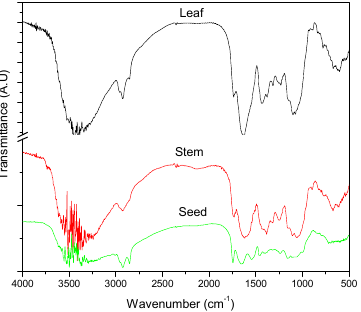
Figure 4. FTIR spectra of the okra leaves, okra stem, and okra seeds.